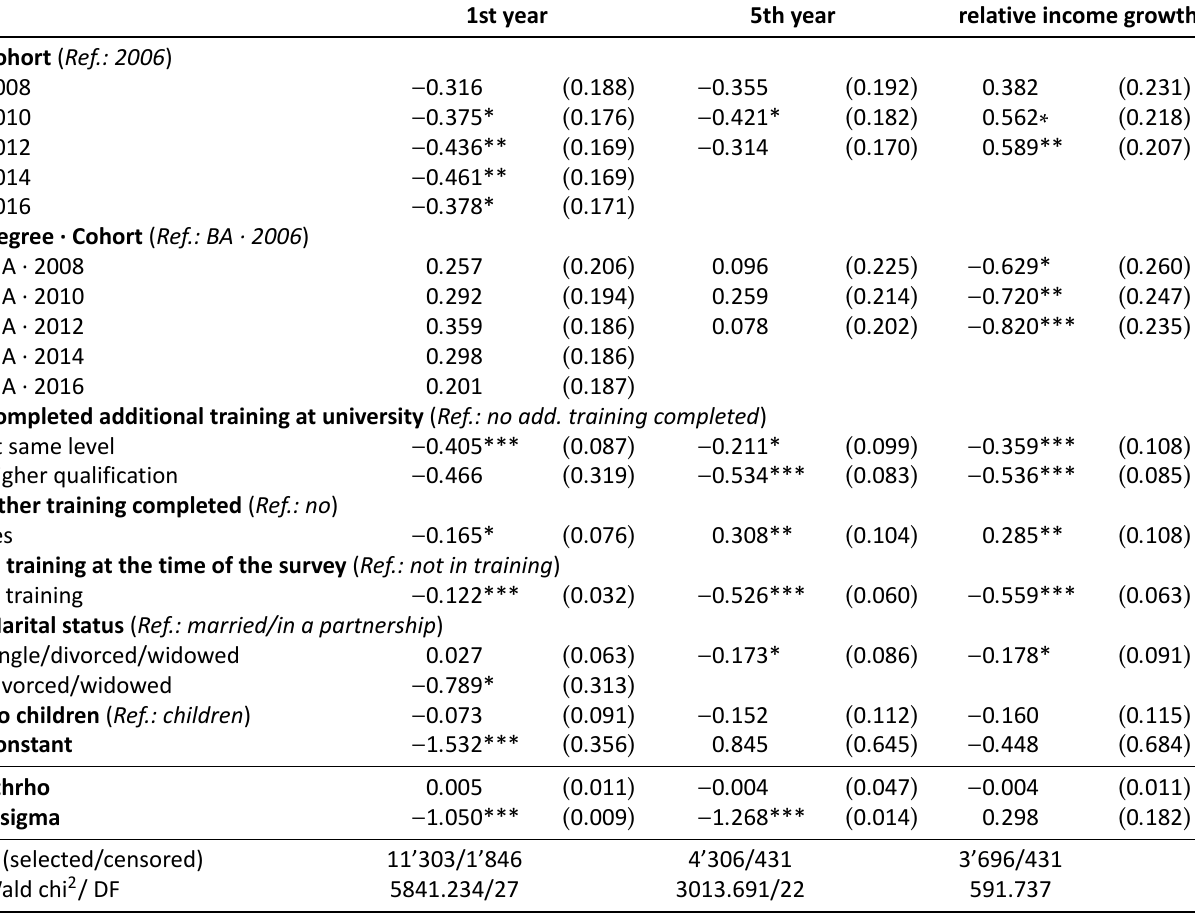
Table A5. (Cont.) Men’s monthly income (log.) in the first and fifth year after graduation and their relative income growth; models with interaction terms—shown in Figure